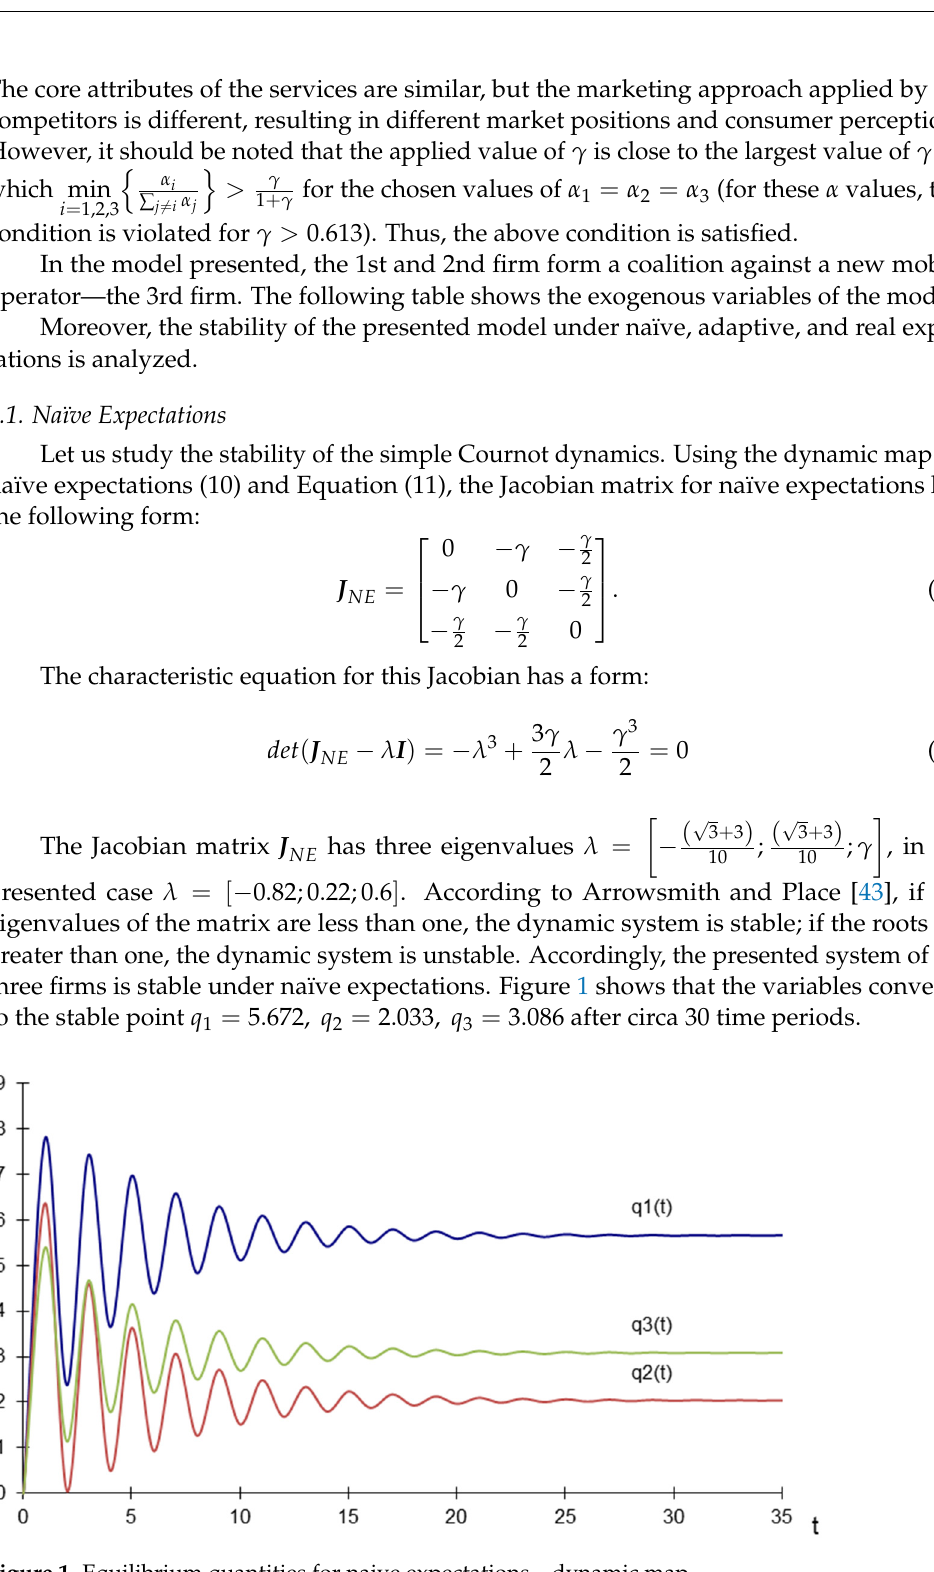
Figure 1. Equilibrium quantities for naive expectations—dynamic map.